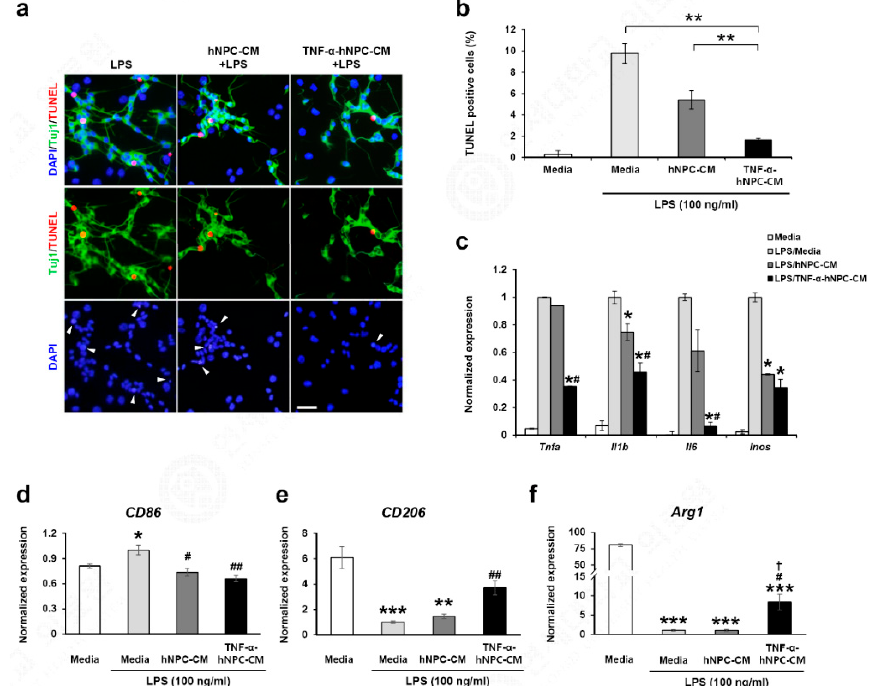
Figure 6. TNF- α -pretreated hNPC-CM prevented neuronal damage induced by reactive microglia in neurons and microglia co-cultures. ( a ) Neuron and microglia co-cultures were treated with media, hNPC-CM, or TNF- α -hNPC-CM in the presence or absence of 100 ng / mL LPS. Cell-specific markers and a separate nuclear stain were combined with a TUNEL assay. TUNEL: TMR red (red), neuron-specific marker: Tuj1 (green), nucleus-specific marker: DAPI (blue). The total cell number per field was established by counting individual nuclei (blue). Turning the laser channel on / o ff for nuclear stain (blue) allowed easy detection of overlap between cell-specific (green) and TUNEL (red) markers (middle panel). Scale bars, 25 µ m. The nuclei indicated by arrowheads overlap with the TUNEL + apoptotic cells (lower panel). ( b ) Quantitative analysis of TUNEL assay. TUNEL-positive cells were counted from four images of randomly selected fields per group, and at least 100 cells were counted per field. Data are presented as the means ± SEM from three independent experiments performed in triplicate. ** p < 0.01. ( c ) Evaluation of pro-inflammatory cytokines in BV2 cells after 24 h. The expression of Tnfa , Il1b , Il6 , and Inos was assessed by qRT-PCR. (n = 6 per group). * p < 0.05 vs. LPS / Media; # p < 0.05 vs. LPS / hNPC-CM. ( d – f ) Evaluation of M1 / M2 polarization markers. The microglial phenotypes of BV2 co-cultured with media, hNPCs, or TNF-a-hNPCs were assessed by qRT-PCR of the M1 marker CD86 ( d ), and the M2 markers CD206 ( e ) and Arg1 ( f ) (n = 3 per group). * p < 0.05, ** p < 0.01, and *** p < 0.001 vs. Media only; # p < 0.05 and ## p < 0.01 vs. LPS / Media; † p < 0.05 vs. LPS / hNPC-CM. Data are presented as the mean ± SEM.